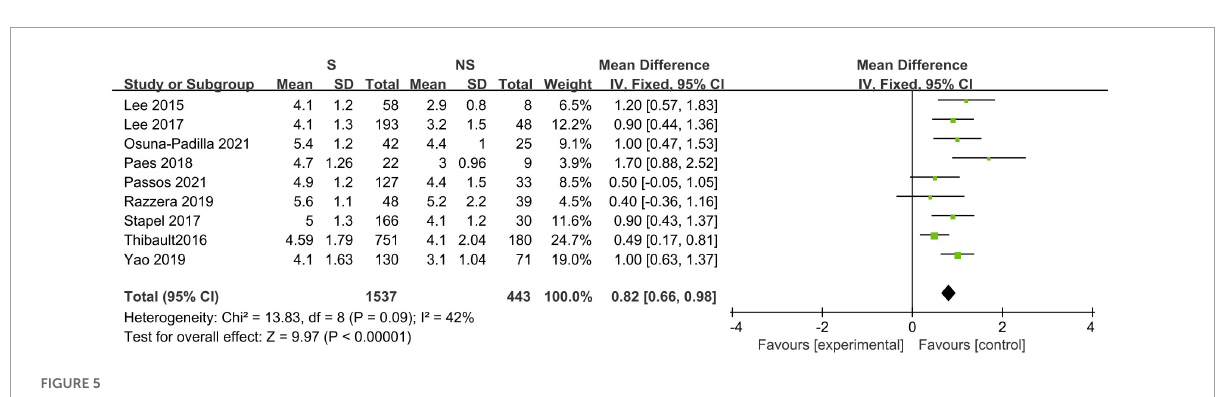
FIGURE5 Forest plot demonstrating the association between phase angle (as continuous variable) and mortality in critically ill patients and the pooled